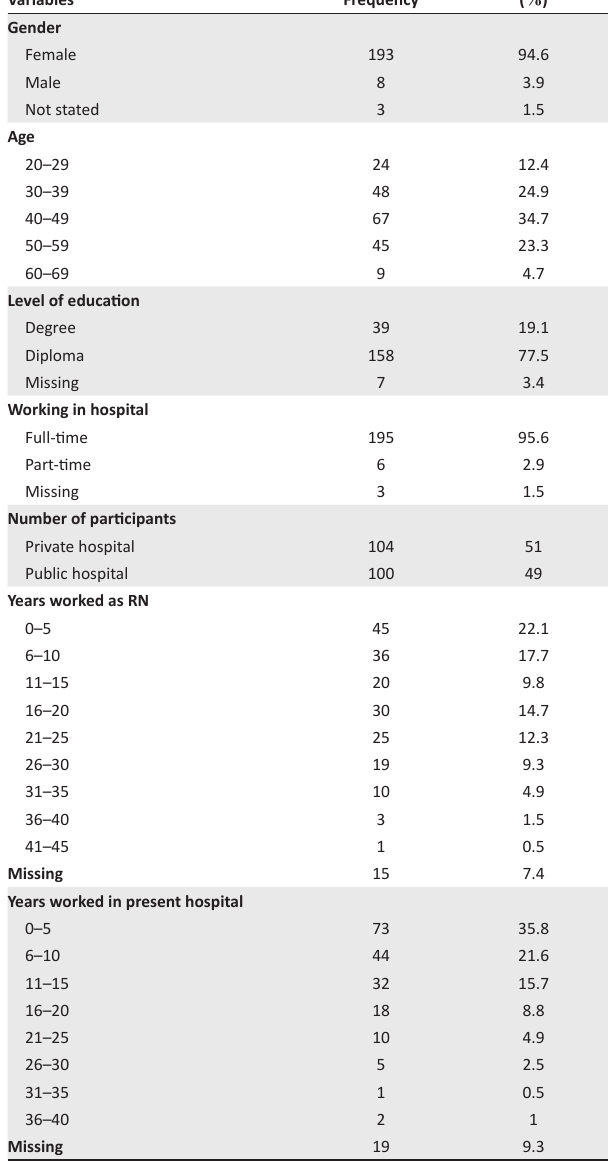
TABLE 1: Demographic information of participants ( n = 204).